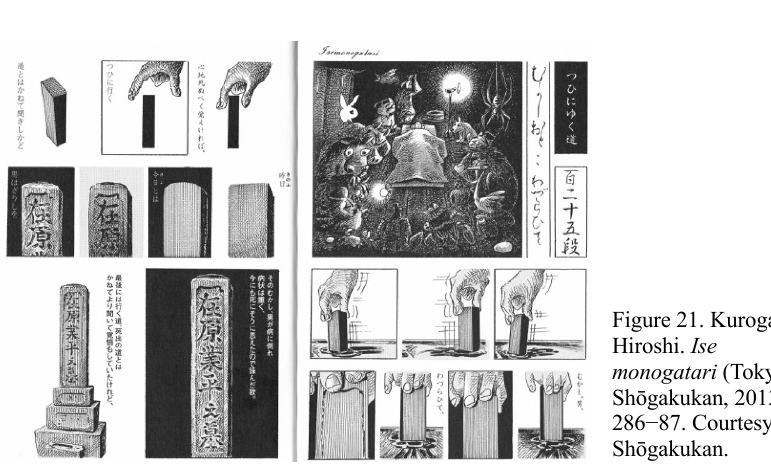
Figure 20. Kurogane